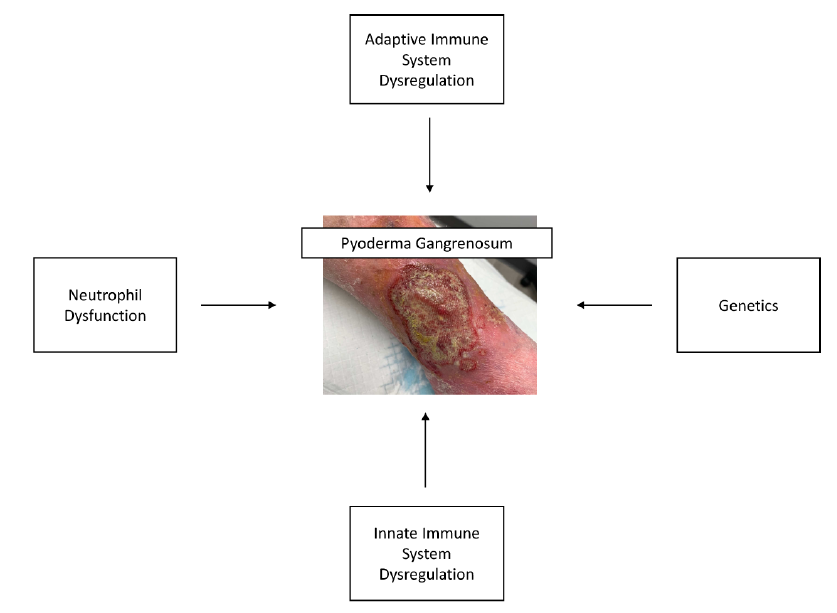
Figure 1. Pathophysiology of pyoderma